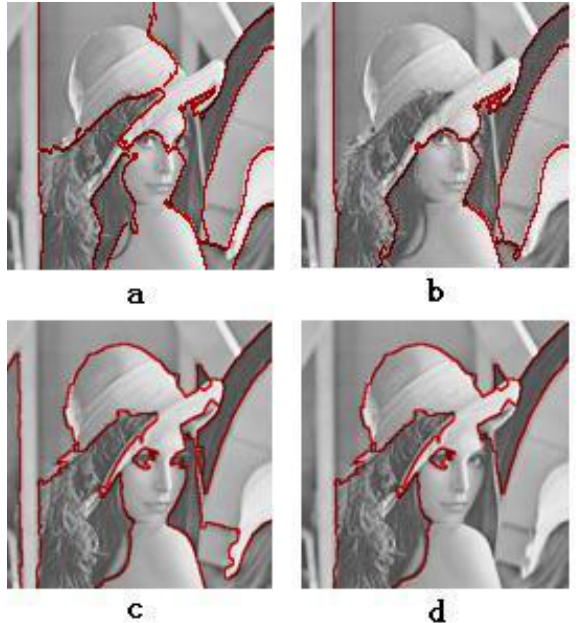
Fig 11. The comparison of segmentation of „Lena‟ between our method and Normalize Cut algorithm. a and b are divided into 10 and 6 regions respectively by N-Cut algorithm. c and d are divided into 10 and 6 regions respectively by our